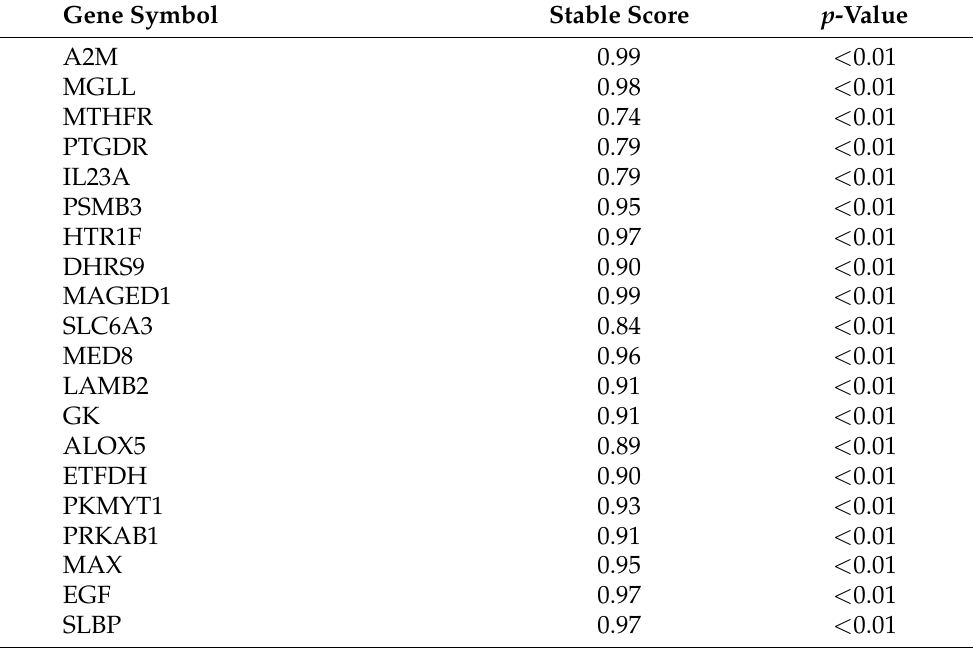
Table 3. The top-20 genes found in the BRCA (breast cancer) dataset. Gene Symbol Stable